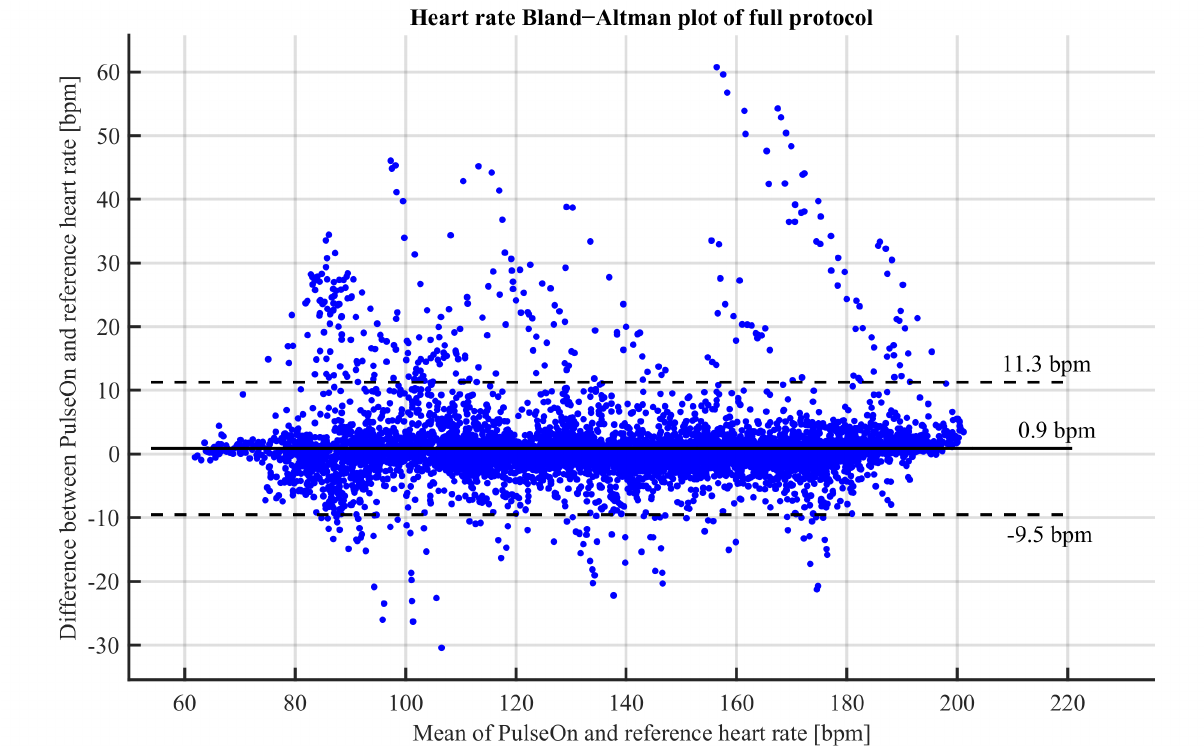
Figure 2. Bland−Altman plot comparing the wrist PPG device and chest strap HR device during maximum exercise protocol in all 24 subjects (solid horizontal line: bias, dashed lines: 95% confidence limits of agreement).